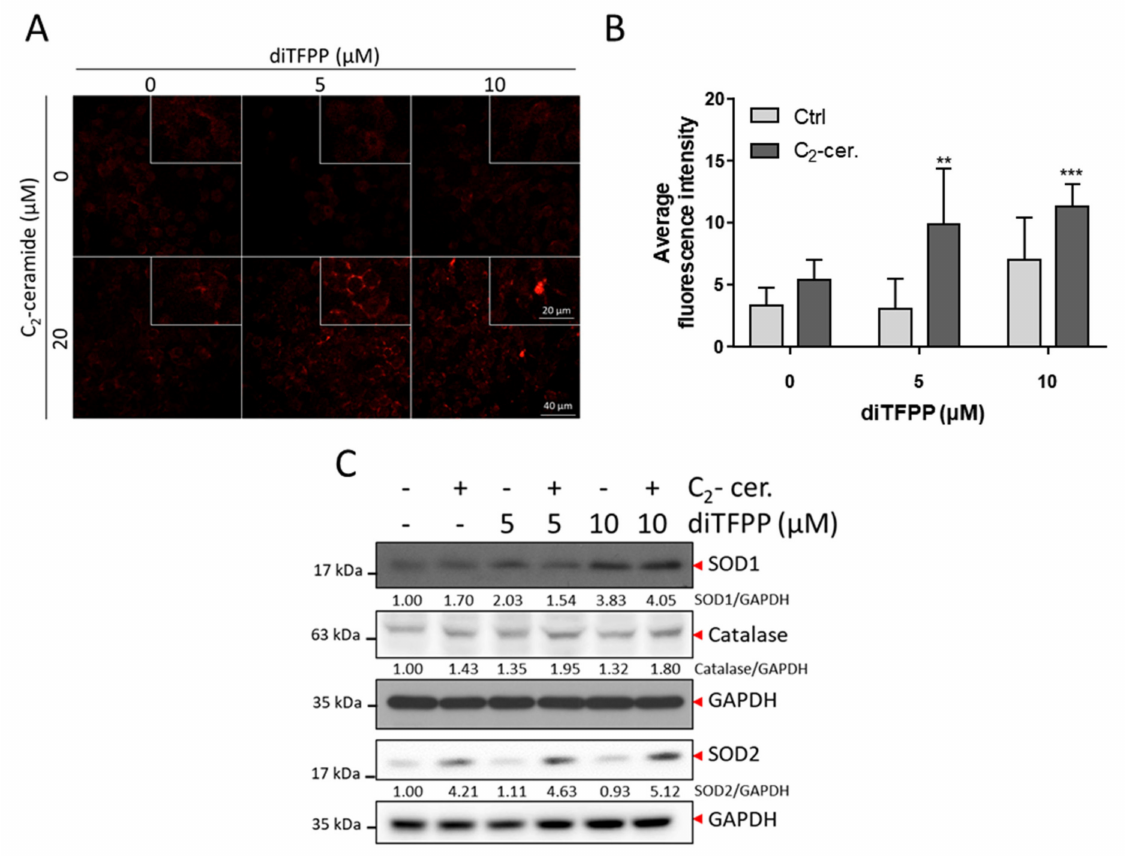
Figure 5. ROS plays a role in diTFPP/C 2 -ceramide-mediated cell death. ( A ) DHE staining with red fluorescence indicated ROS production in diTFPP/C 2 -ceramide-treated HA22T cells. ( B ) The quantification of (A). ** p < 0.01, *** p < 0.001 compared with the control groups. ( C ) Western blot analysis of ROS metabolic protein expression after diTFPP/C 2 -ceramide treatment. GAPDH as an internal